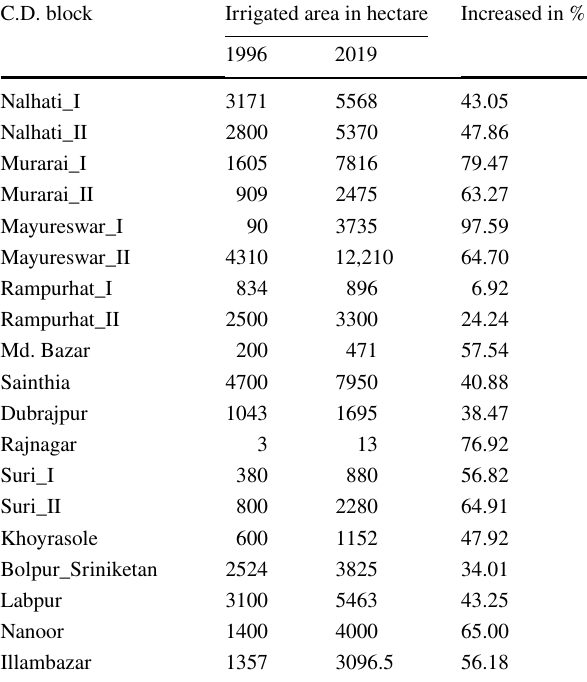
Table 5 Temporal changes of irrigated area C.D. block